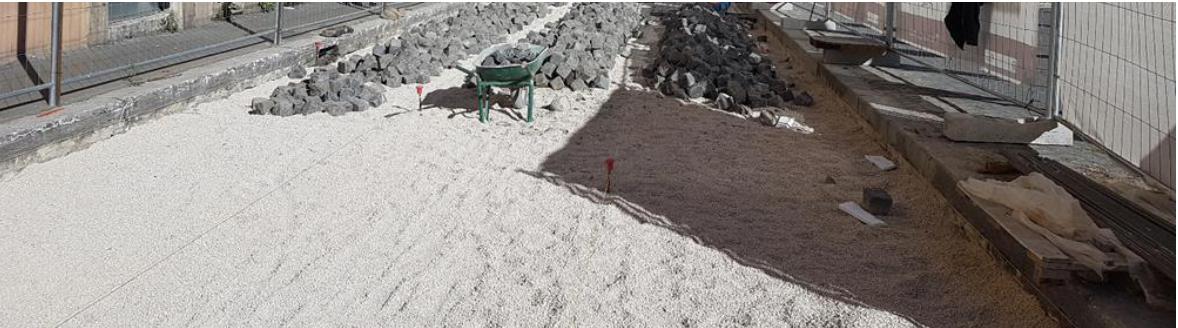
Figure 4. Second phase: construction of the bedding course.